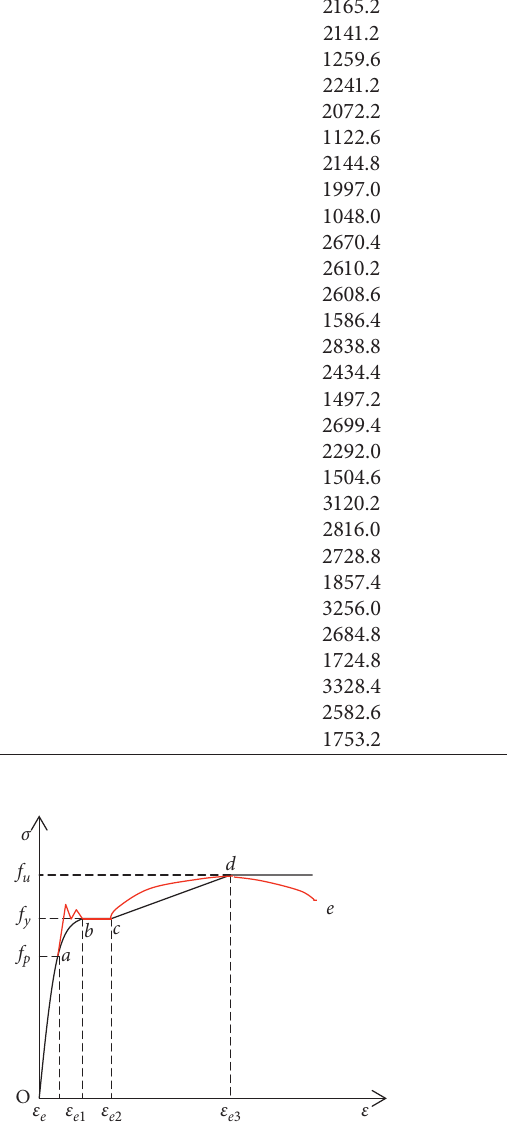
Figure 17: Stress-strain curve of